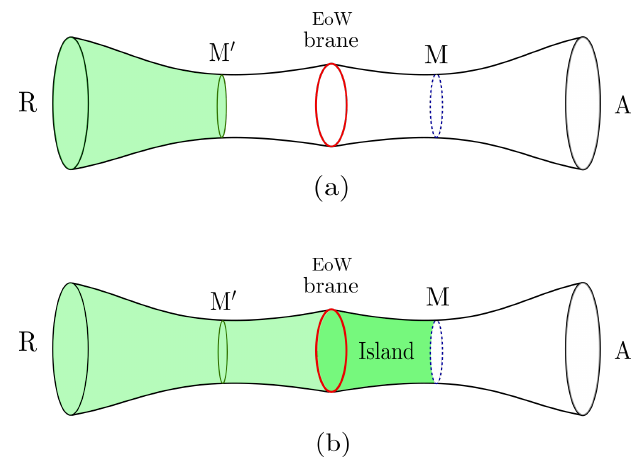
Figure 2. Entanglement wedge of radiation subsystem R (a) before and (b) after Page time. (a) The green shaded region is the EW of R as M 0 is the preferred RT surface. (b) At Page time, the RT surface of R changes to M , which goes through the EoW brane (marked as red) and contains part of the real black hole (the island region is shown by deep green). Here the blued dotted circle denotes the RT surface of the real black hole. The left side of the EoW brane is the inception side, whereas the right side of it is the real side.